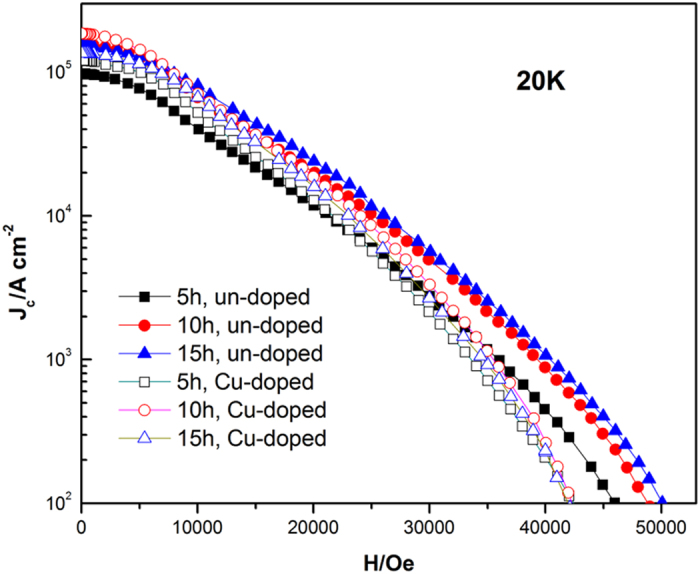
The measured Jc-H characteristics of the sintered samples at 20 K.